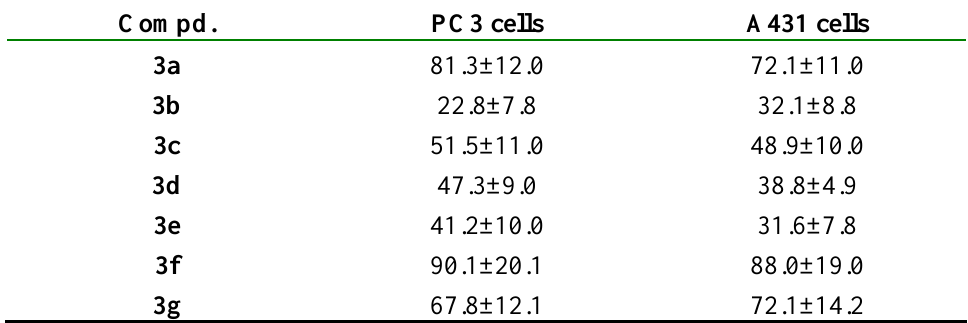
Table 3 . Inhibition rate ( x ±s) (%) (10µg/mL) of compounds 3a - 3g in 72 hours ( P <0.01).